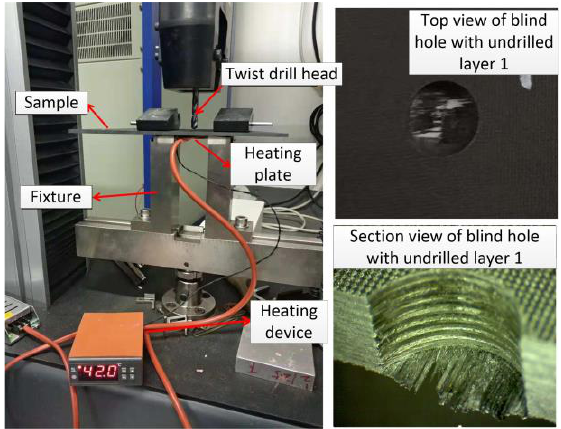
Figure 13. Experimental platform for critical axial force testing.